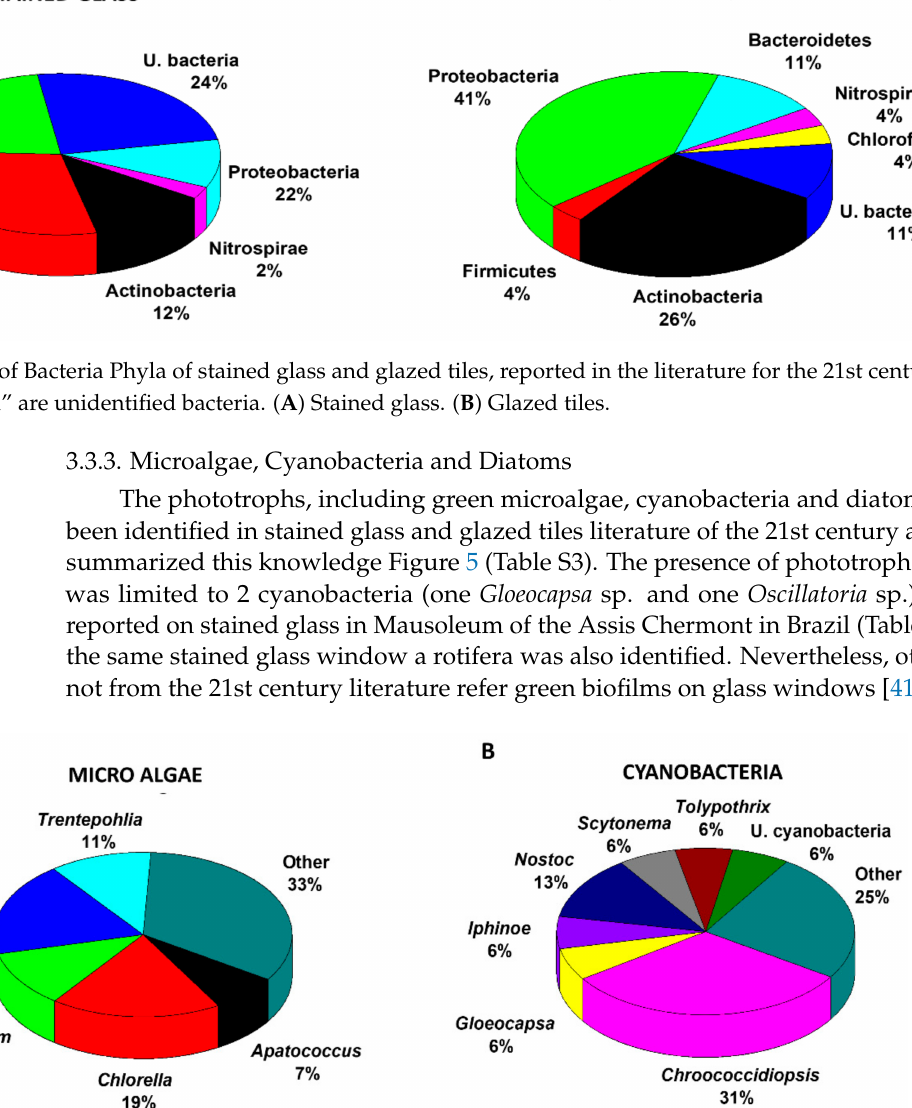
Figure 5. Relative percentage of genera of phototrophic microorganisms reported in the literature for the 21st century on glazed tiles. ( A ) Micro algae and ( B ) Cyanobacteria. The category “Other” refers to a compilation of several genera that occurs less than 3.4% and “U. cyanobacterium” are unidentified